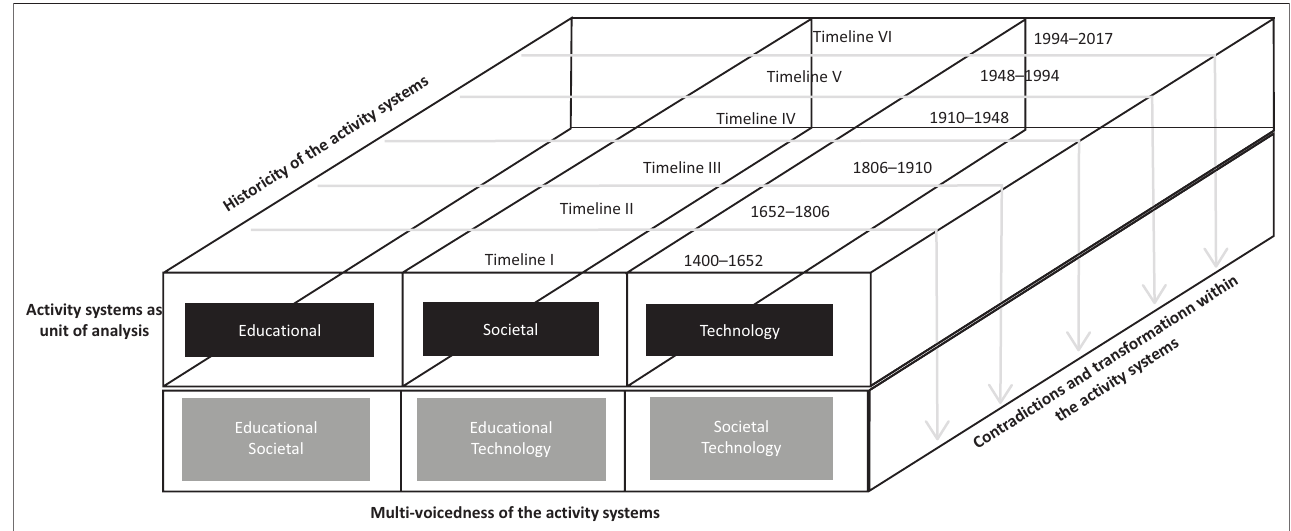
FIGURE 1: Visual representation of the interrelated components of this historical research